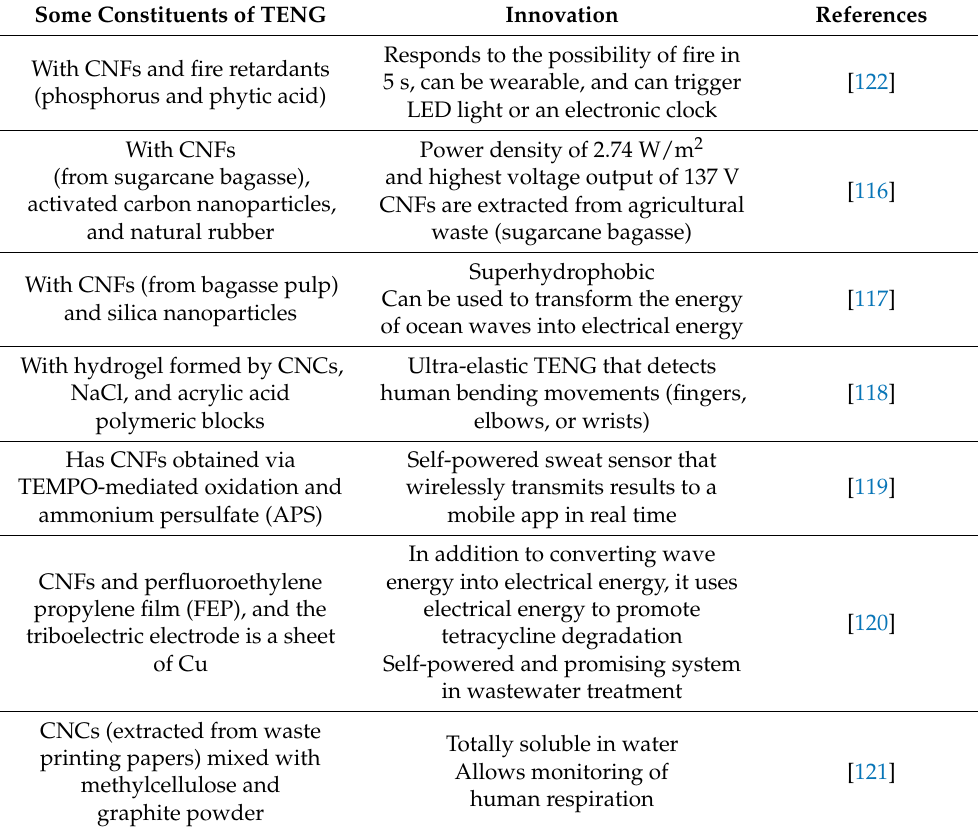
Table 9. Innovative TENGs based on nanocelluloses (published from 2022 to 2023). Some Constituents of